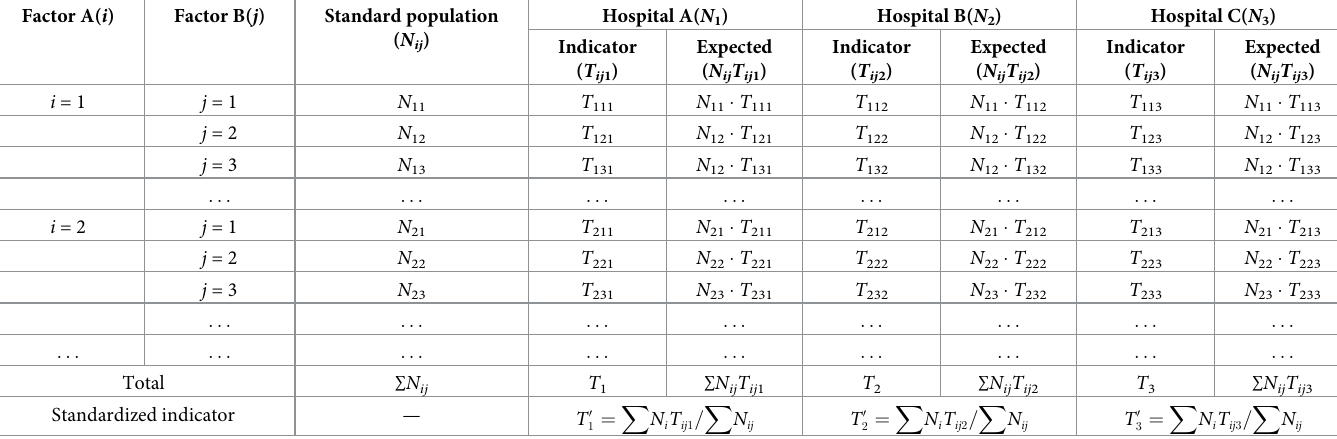
Table 2. Stratified standardization method of medical service indicator among three